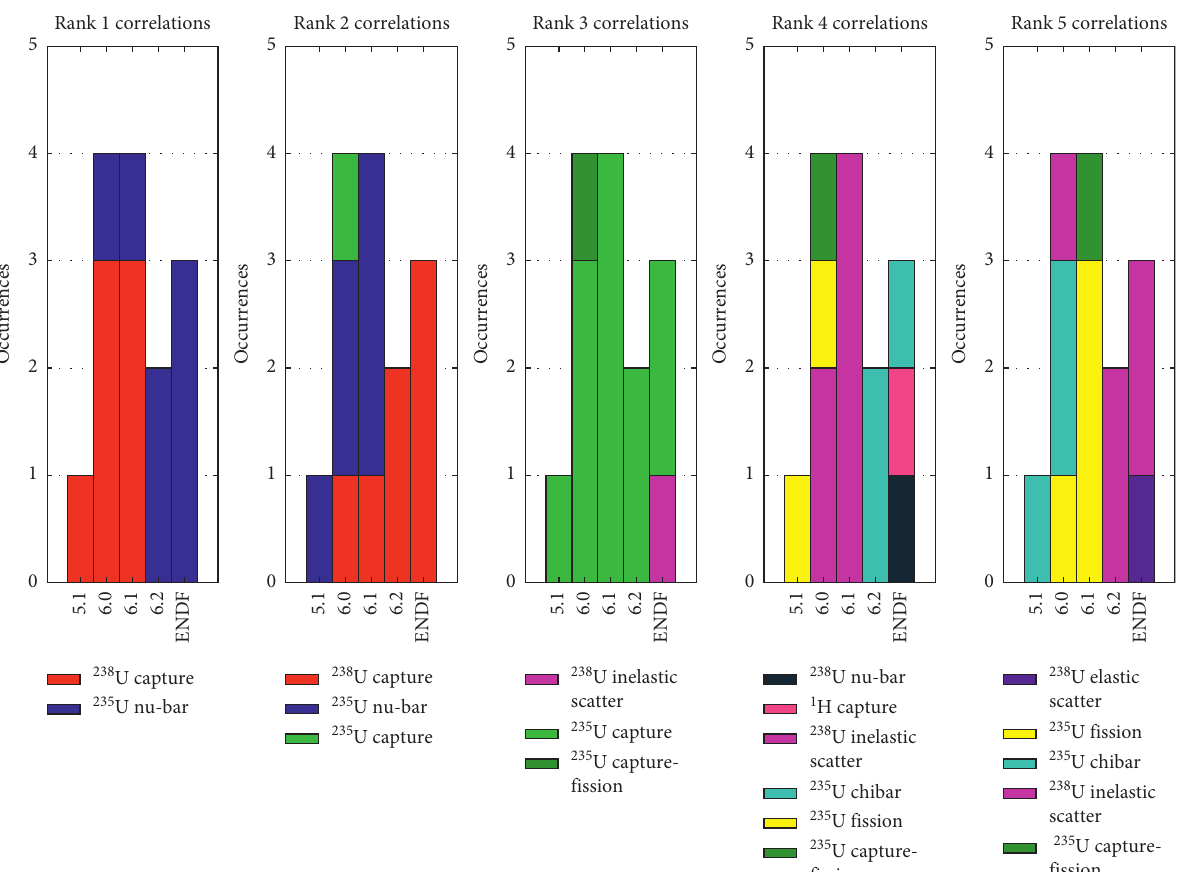
Figure 5: Ranking of the five nuclide-reaction pairs with the highest contribution to the k-inf uncertainty. SX � SCALE X covariance library and E7.1 � ENDF/B-VII.1 covariance library.